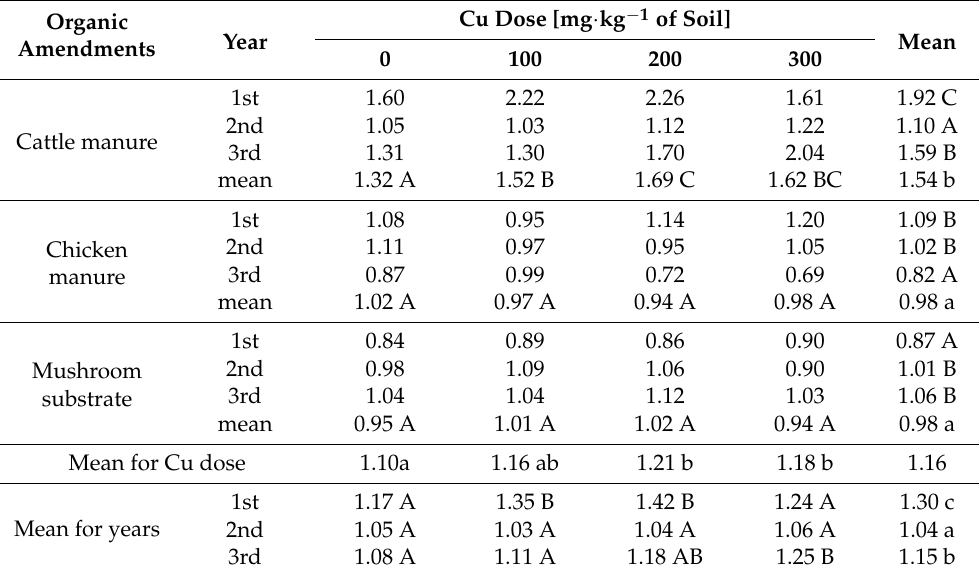
a,b,c—means for investigated factors with different letters (in the columns for organics amendments and for ears but in the row for cooper doses) are significantly different. A,B,C—means for the interaction of the studied factors with uppercase different letters in the rows and in the column ‘Mean’ of the table are significantly different.